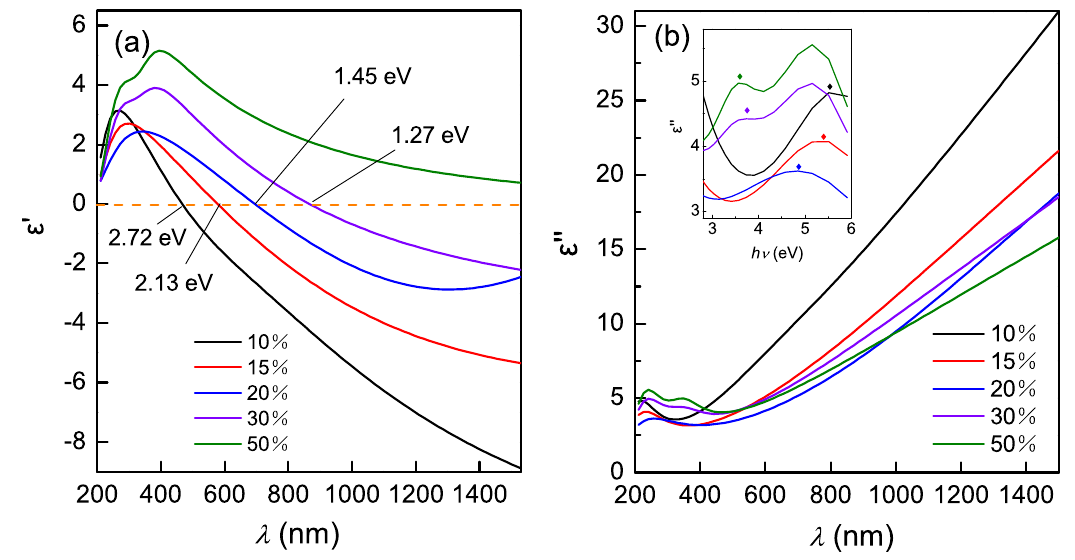
Figure 3. Real part ε (cid:48) ( a ) and imaginary part ε (cid:48)(cid:48) ( b ) of complex permittivities of the (Ti, Zr)N x films deposited with different nitrogen flow ratio. The inset shows the ε (cid:48)(cid:48) in the near-ultraviolet region, with local peaks marked with